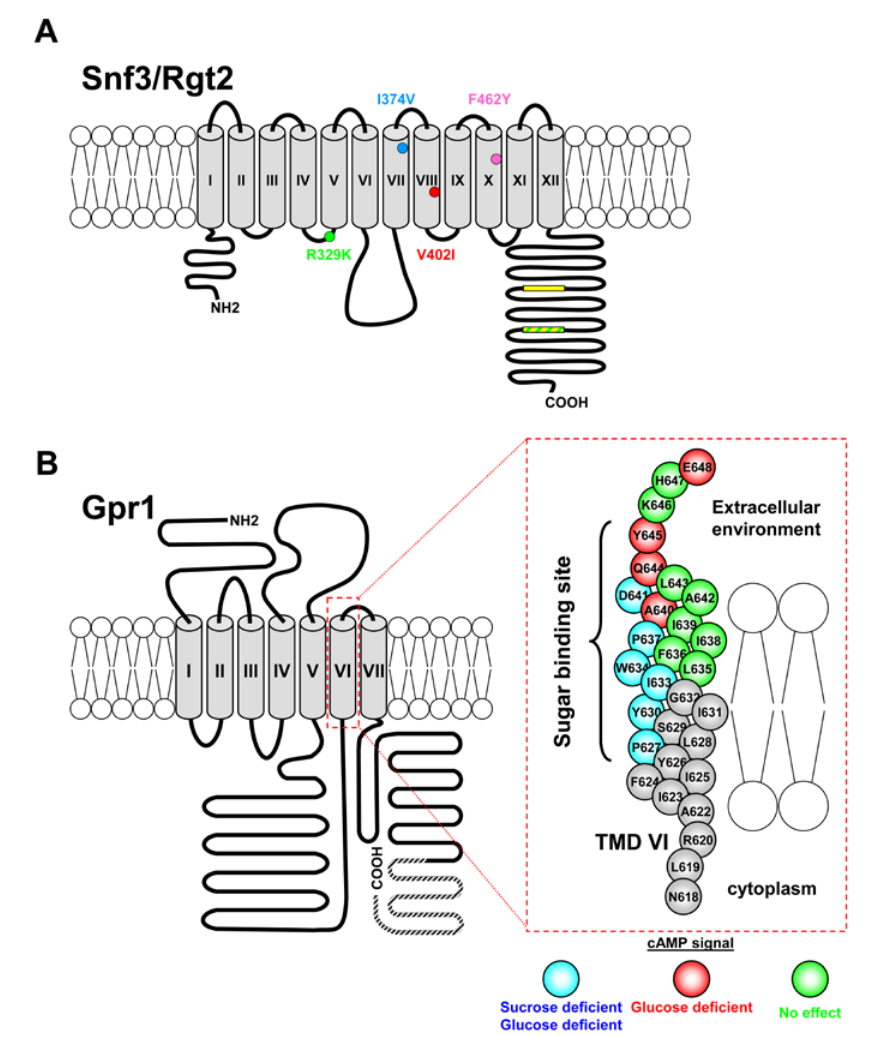
Figure 2. Structure of the Gpr1 Glucose Receptor and of the Snf3/Rgt2 Glucose Sensors. (a) The two-dimensional transmembrane topology of the Rgt2p and Snf3p glucose sensors, based on the model of the mammalian Glut1 glucose transporters. The predicted transmembrane domains are numbered I to XII. Aminoacidic substitutions which alter glucose signaling are depicted as coloured dots (see main text for details). Yellow box indicates a repeated sequence of 25 amino acids in the carboxyl-terminal tail of both Rgt2p and Snf3. A second copy (yellow/green shaded box) is also present in the Snf3 carboxy-terminus. (b) The putative structure of Gpr1 model is based on the similarity with GPCRs found in higher eukaryotes [89]. The predicted transmembrane domains are numbered I to VII. The C-terminal 99-amino-acid sequence interacting with Gpa2 is highlighted. The magnification of the transmembrane domain VI shows the residues (likely located adjacent to the putative sugar binding site) whose replacement with cystein affects the glucose induced cAMP signaling or both the glucose- and saccharose-induced cAMP signaling. Images adapted from references 14, 87 and